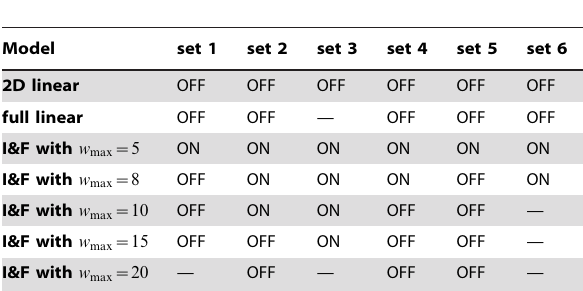
Table 2. Parameter sensitivity of STDP with subtractive